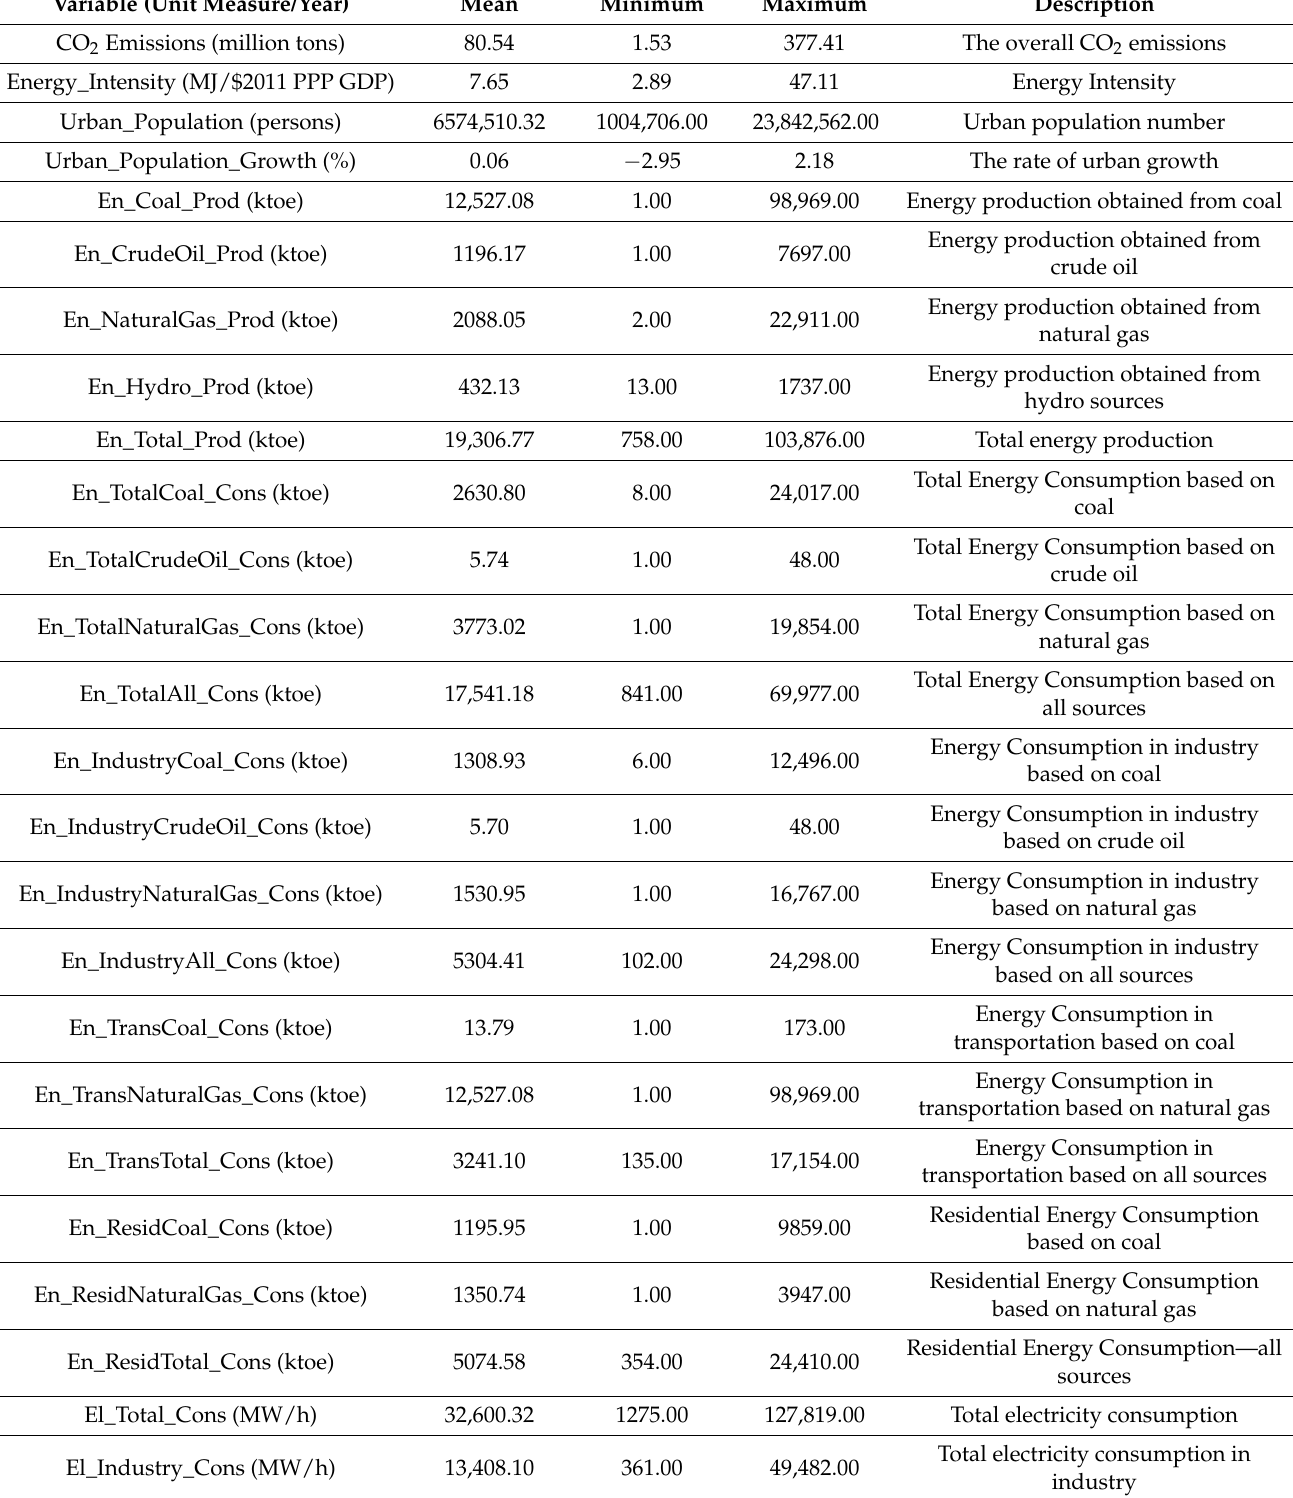
Table 1. Dataset parameters